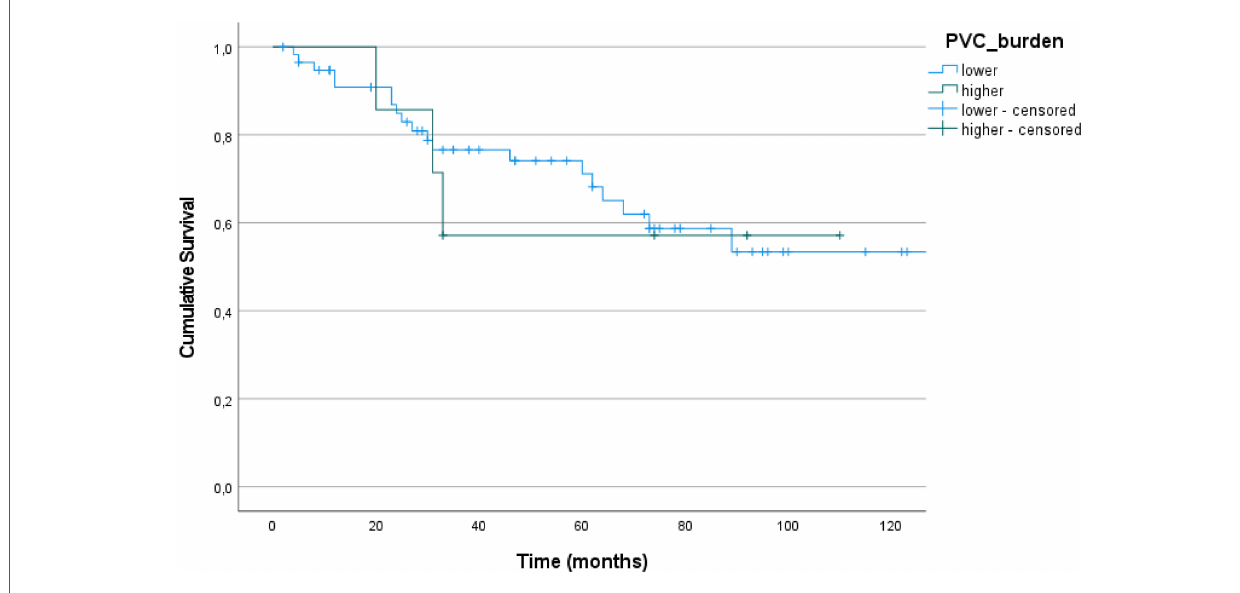
FIGURE 3 Kaplan – Meier plots (+=censored data) for survival of patients with lower ( n =51) and higher ( n =7) PVC burden.